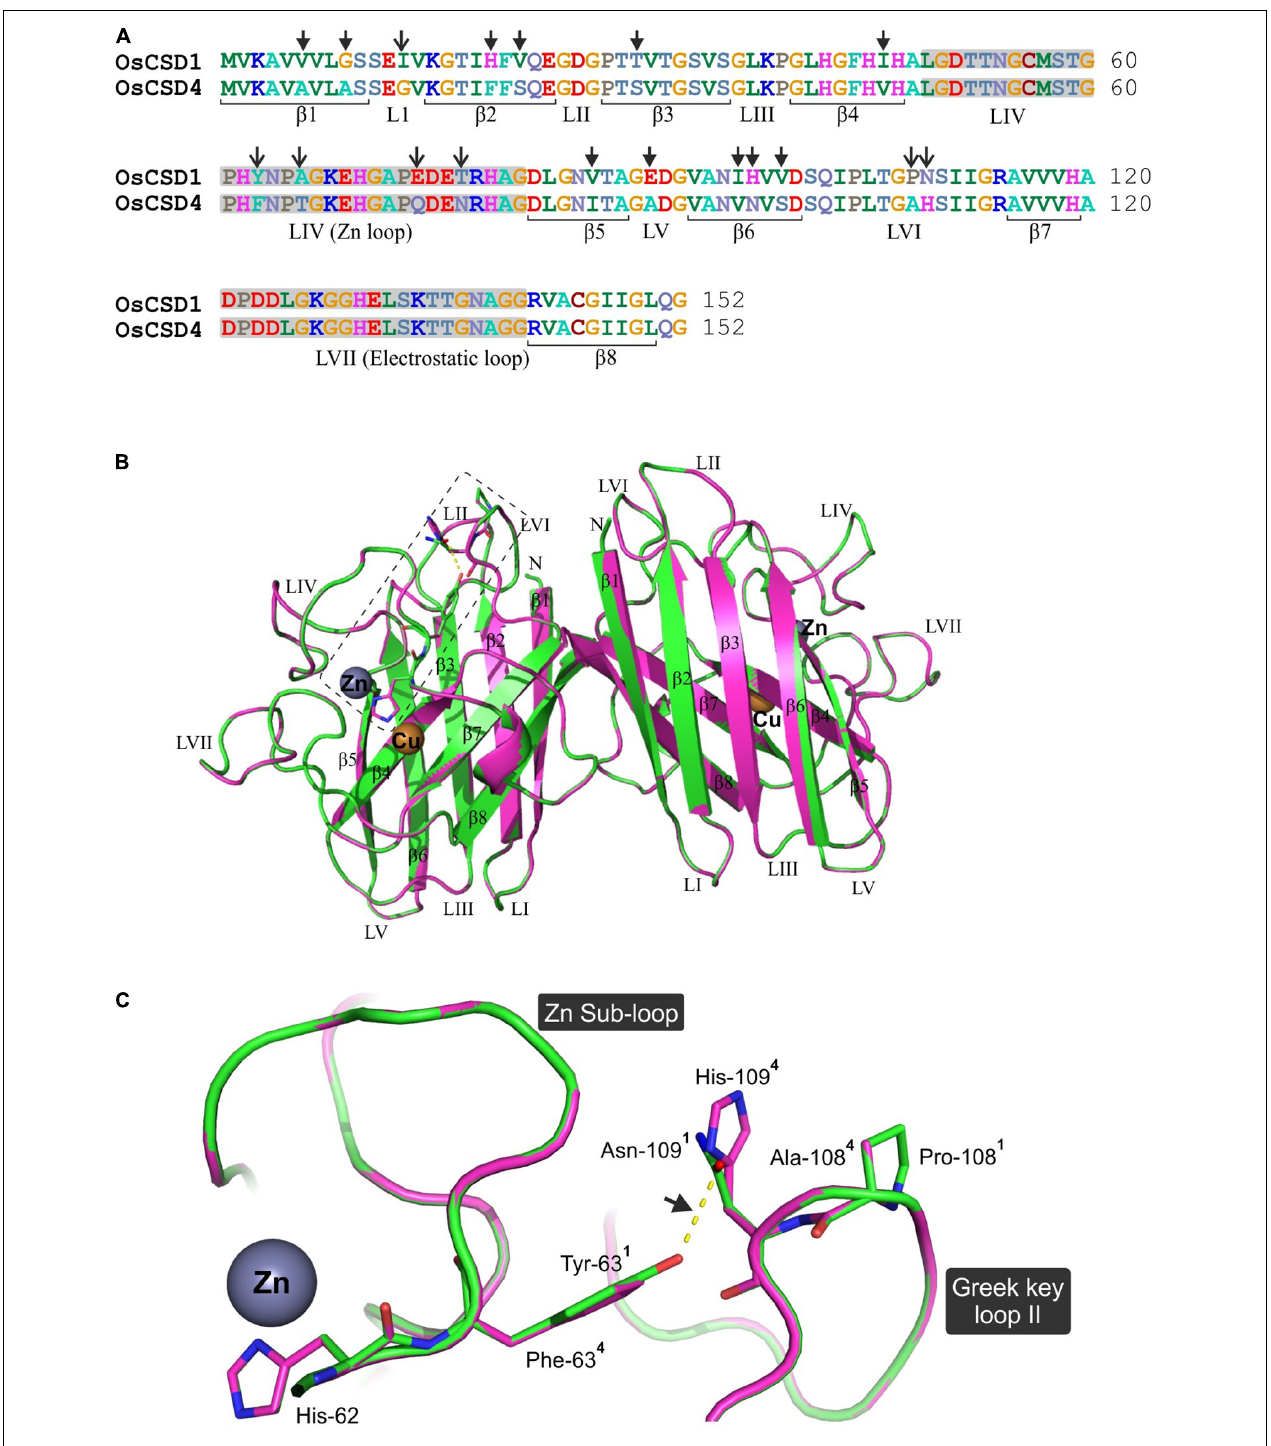
FIGURE 7 | Comparative in silico structural analysis of two rice cytosolic CSDs. (A) Pair-wise alignment of OsCSD1 and OsCSD4 amino acid sequences. The arrows show the positions of 18 amino acid variations affecting the beta strands ( β ) and loop (L) regions. (B) Dimeric superposed 3D homology models of OsCSD1 (green) and OsCSD4 (magenta) generated using the SWISS MODEL workspace using S. lycopersicum CuZn SOD crystal structure (PDB ID: 3PU7) as template. Beta strands ( β 1- β 8), loops (LI-LVII), and positions of Cu and Zn metal co-factors are indicated. (C) Enlarged view of the rectangular region (marked in B ) to show the effect of amino acid substitutions on structural variations in Zn sub-loop and Greek key loop II regions of OsCSD1 and OsCSD4. The superscripts indicate the residues in two proteins ( 1 : OsCSD1 and 2 : OsCSD4), while an arrow shows H-bond between Asn-109 and Tyr-63 (OsCSD1).